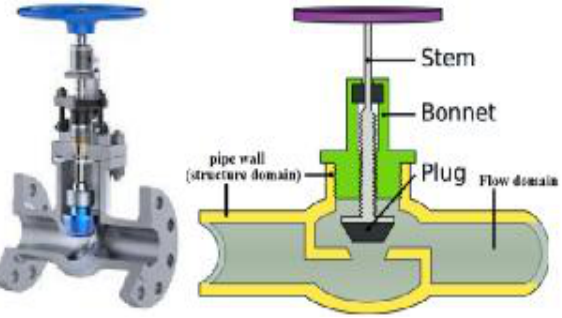
Fig. 4. Schematic diagram of globe valve.